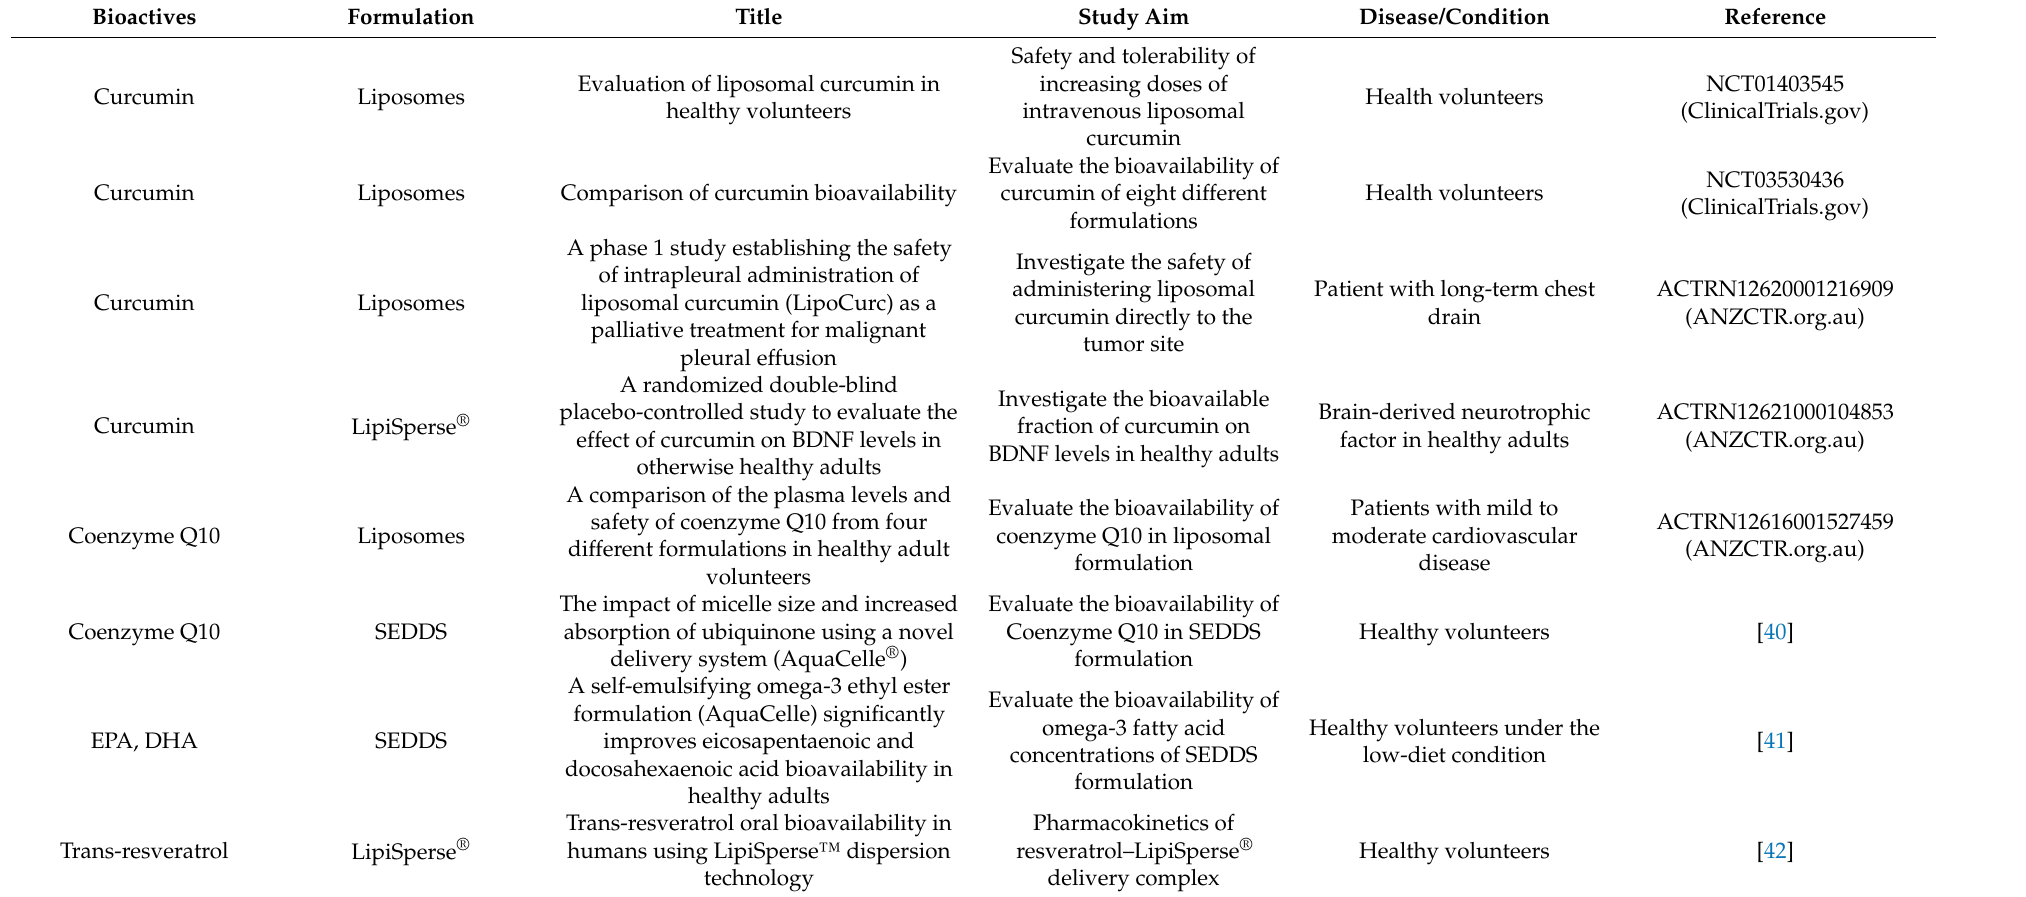
Table 2. Clinical trials on lipid-based